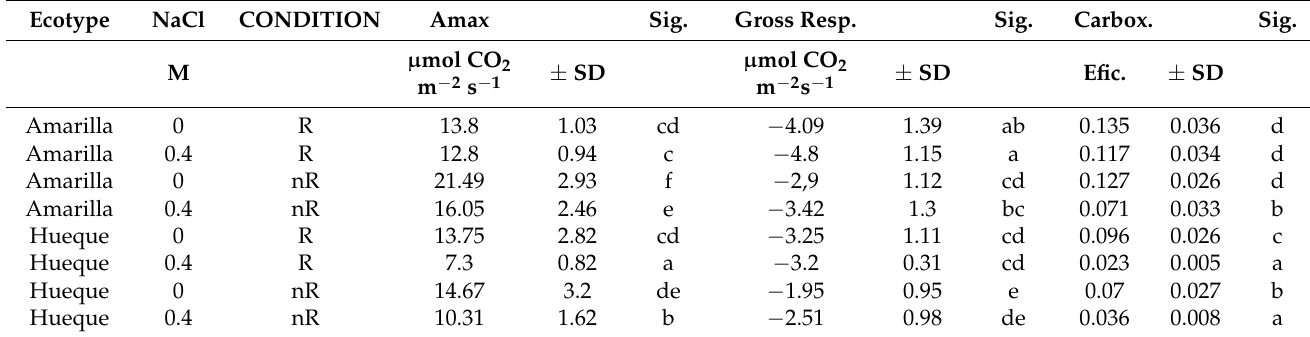
R: with stomatal restriction; nR no stomatal restriction; Amax: Maximum assimilation rate; Gross resp.: Gross respiration (dark and photorespiration); Carbox. Efic.: Carboxylation efficiency; Different letters indicate Significance level ( p ≤